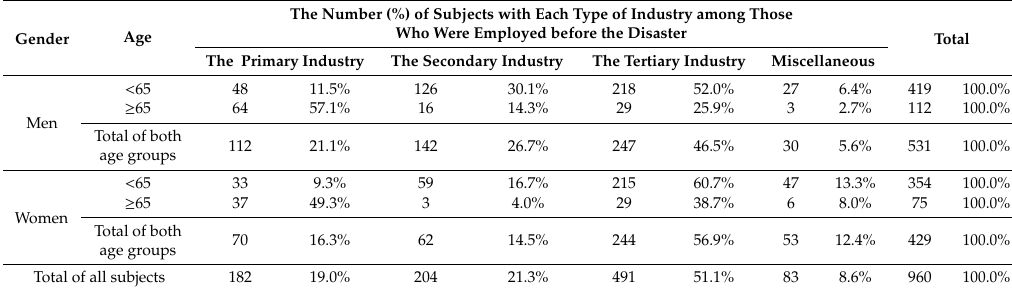
Table 3. The number (%) of subjects with each type of industry among those who were employed before the Great East Japan Earthquake.